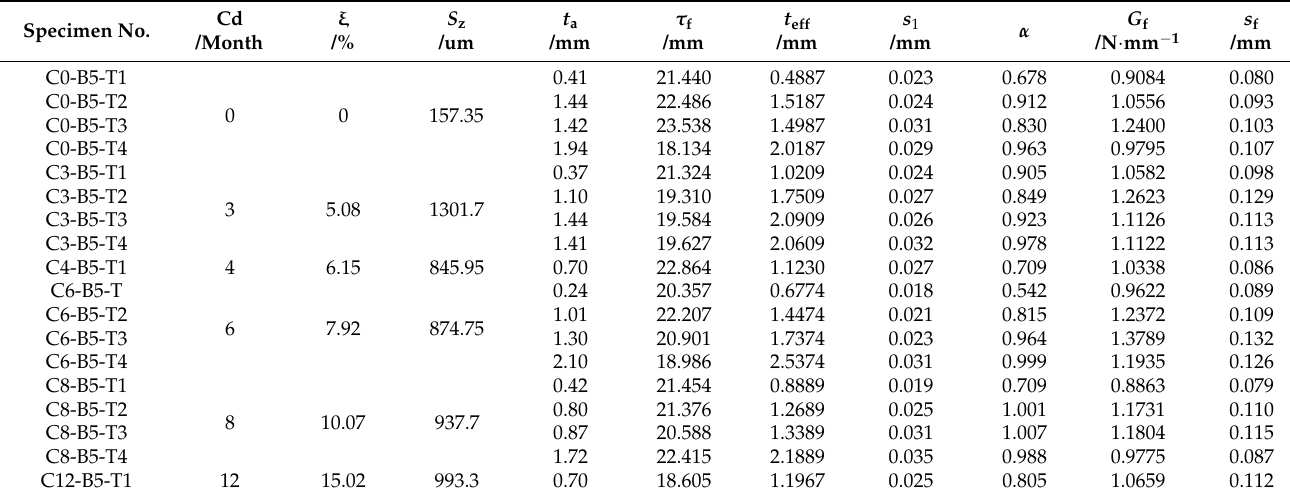
Table 3. Characteristic value of bond properties.